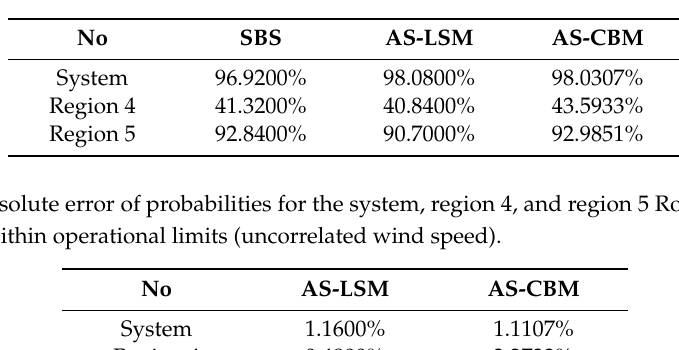
Table 2. Probabilistic distribution of the system, region 4, and region 5 RoCoF using SBS, AS-LSM, and AS-CBM within operational limits (uncorrelated wind speed).